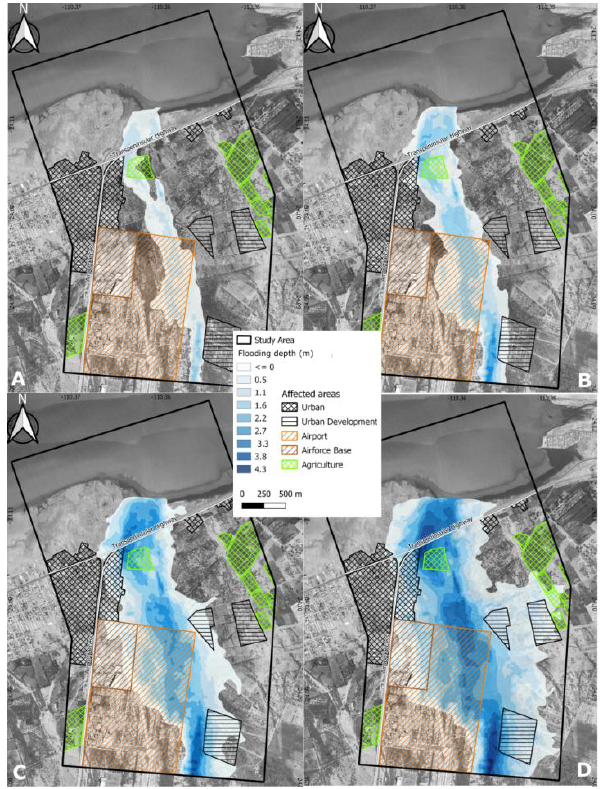
Figure 6. Flooding water elevation maps according to different return periods (RP) in years. ( A ) = RP2,